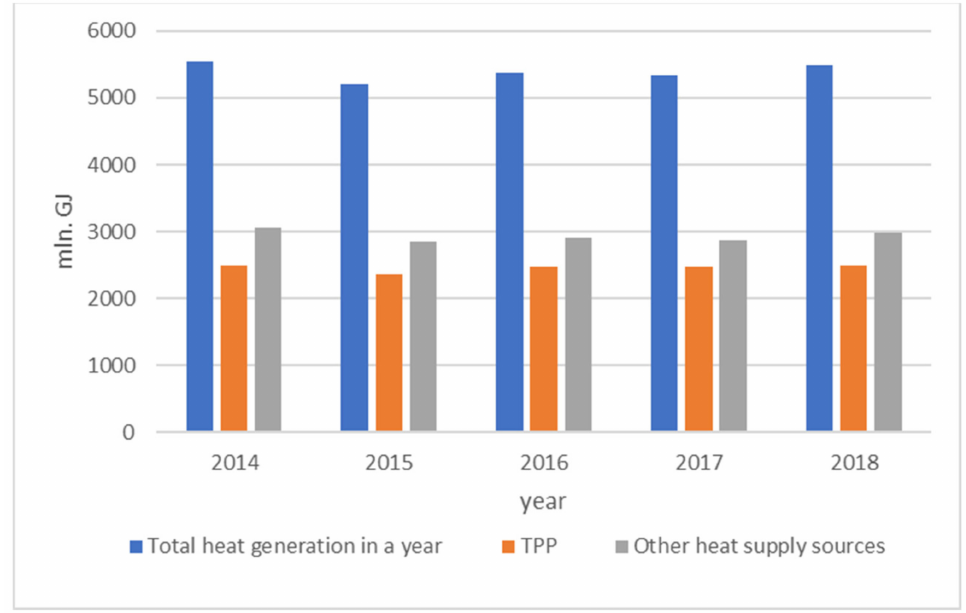
Figure 1. Dynamics of heat energy supply by heat sources according to the data of the Ministry of Energy of the Russian Federation